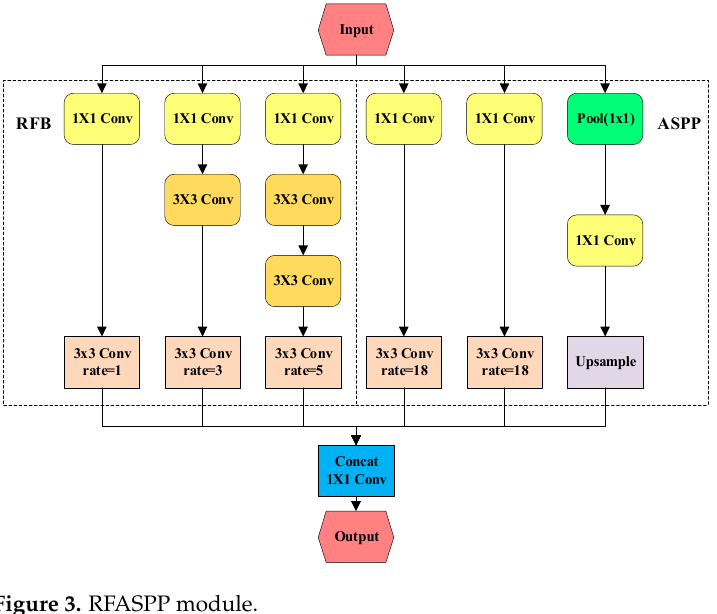
Figure 3. RFASPP module.